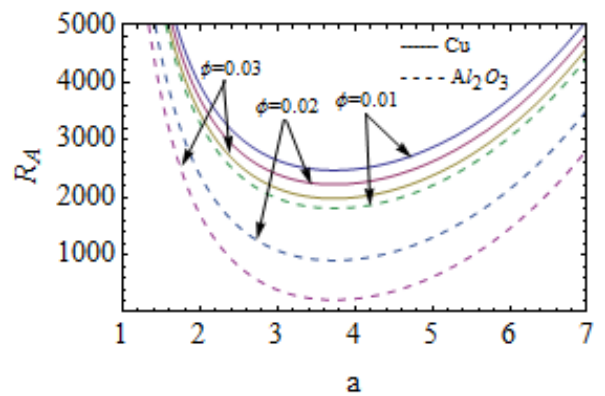
Figure 3. Impact of nanoparticle volume